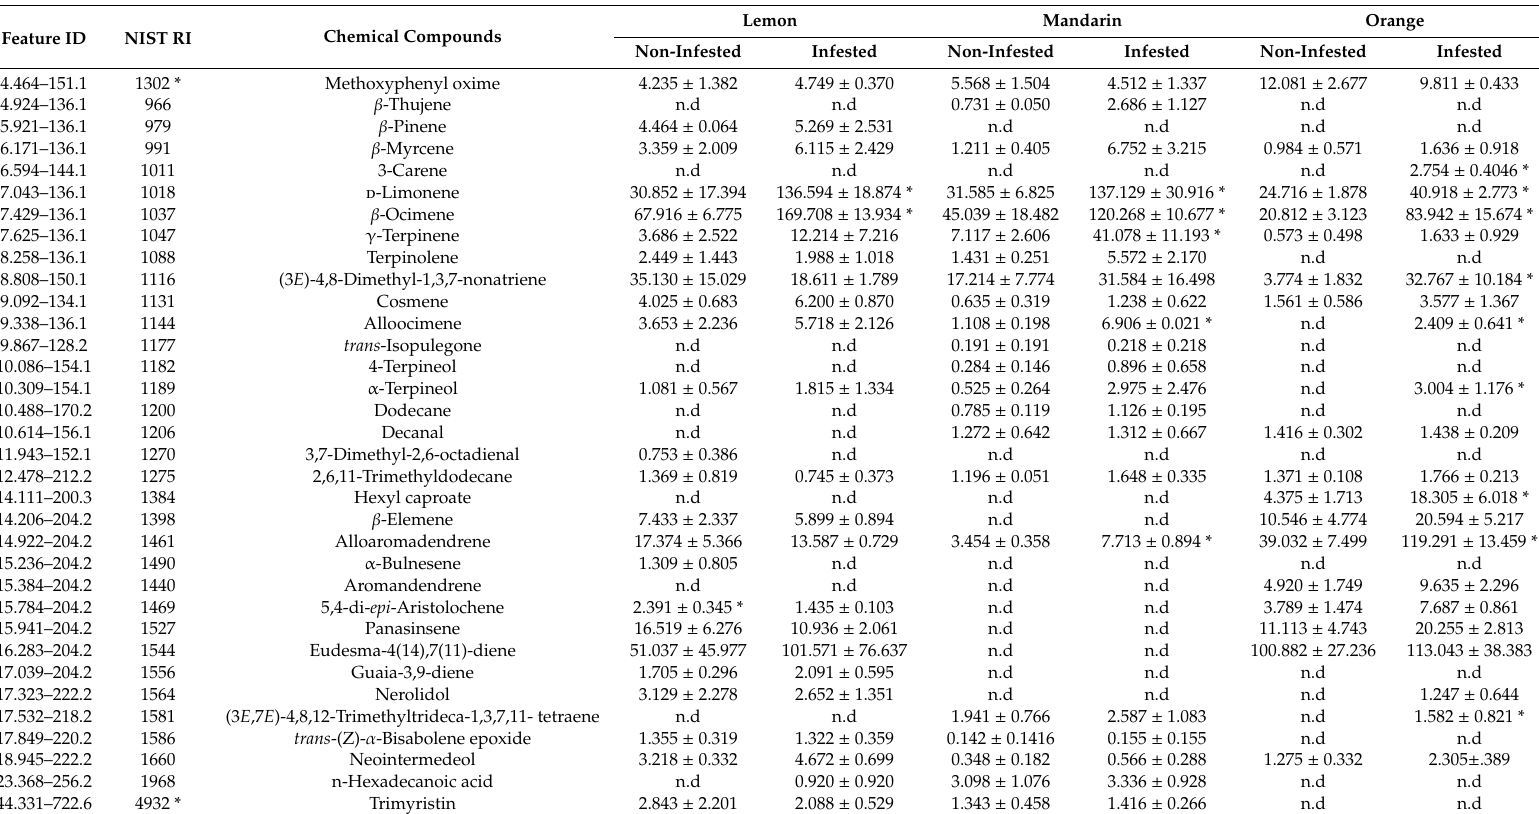
Table 1. Quantities of major volatile compounds released by non-infested and Aonidiella aurantti -infested citrus fruits through headspace sampling by SPME. (GC response—Peak Areas ± SE) × 10 6